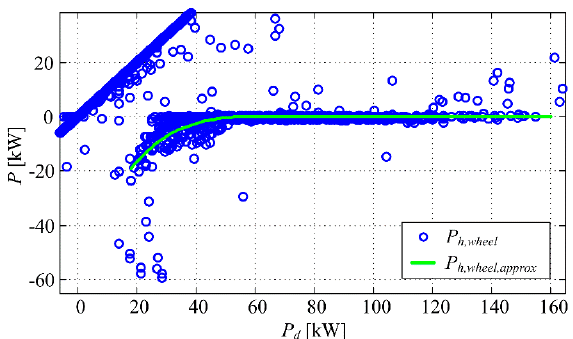
Figure 11. Detail from Figure 10, hydraulic motor power P h,wheel and approximation curve P h,wheel,approx .